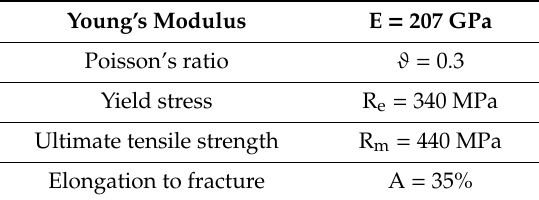
Table 1. Mechanical properties of steel P264GH.